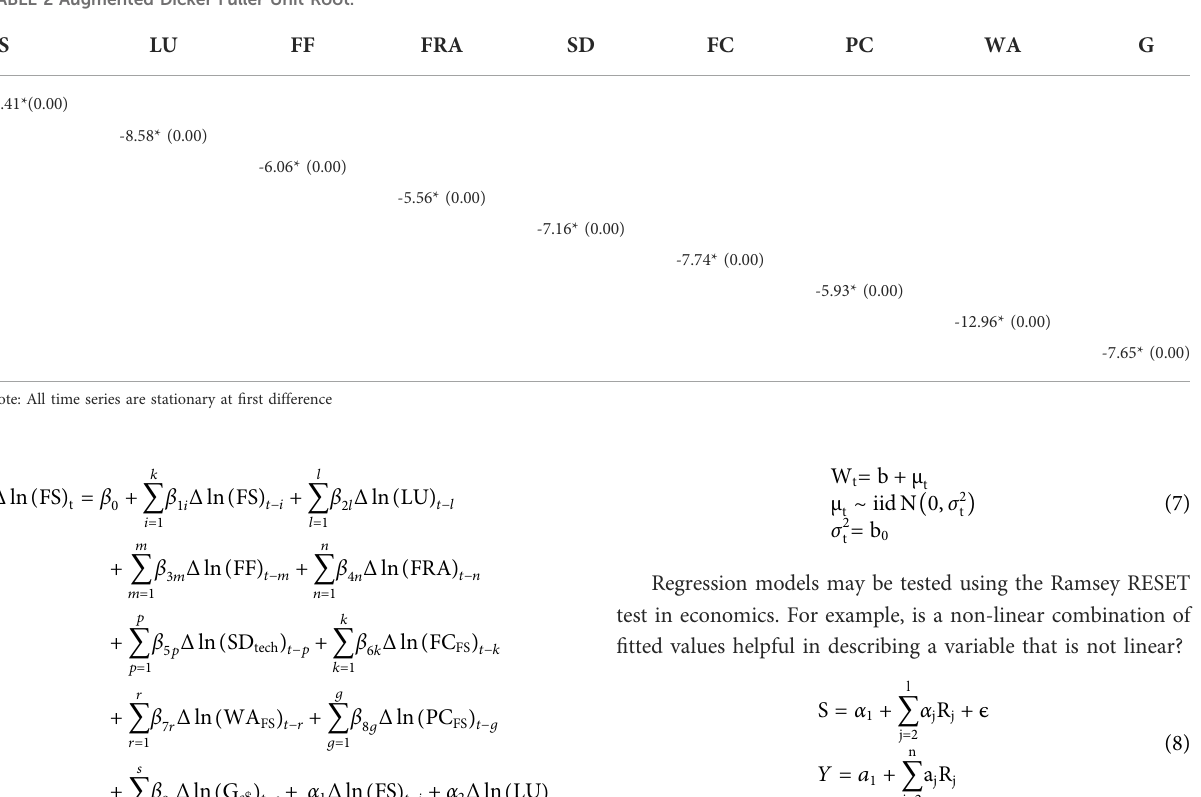
TABLE 2 Augmented Dicker Fuller Unit Root.